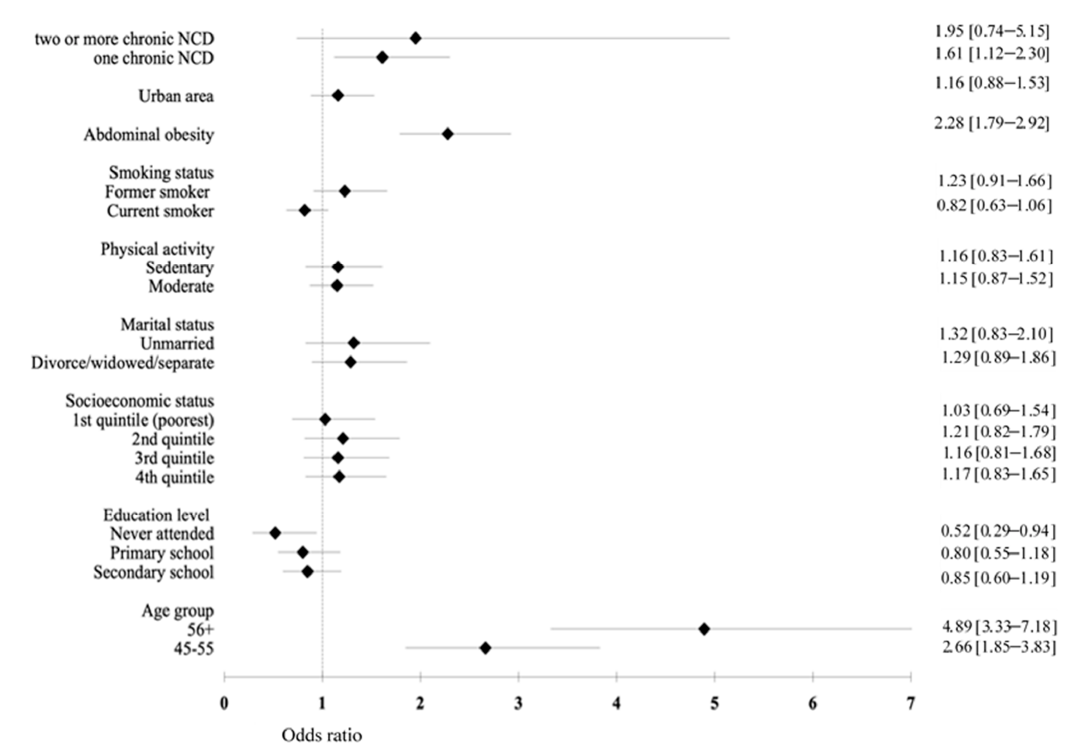
Figure 1. The odds of the association between sociodemographic variables, socioeconomic status, health behavior, and hypertension in men.